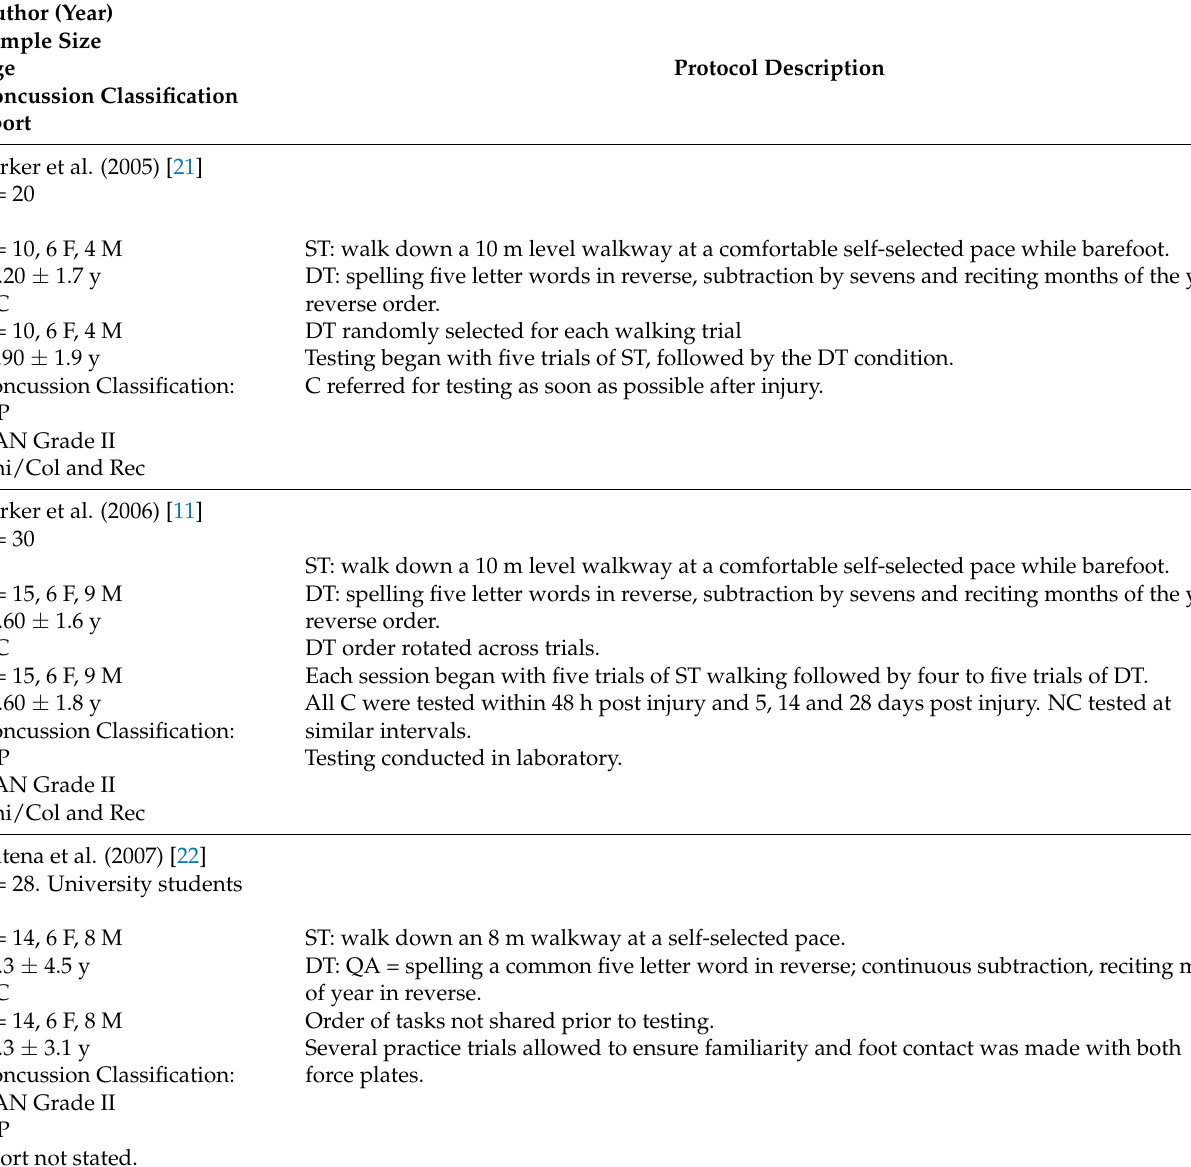
Table 1. Sample groups and protocols from reviewed